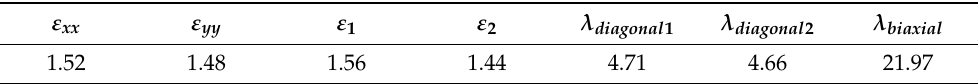
Table 1. Biaxial draw ratio and values of the evolution of the true longitudinal ( ε xx ), transversal( ε yy ), major ( ε 1 ), and minor ( ε 2 )